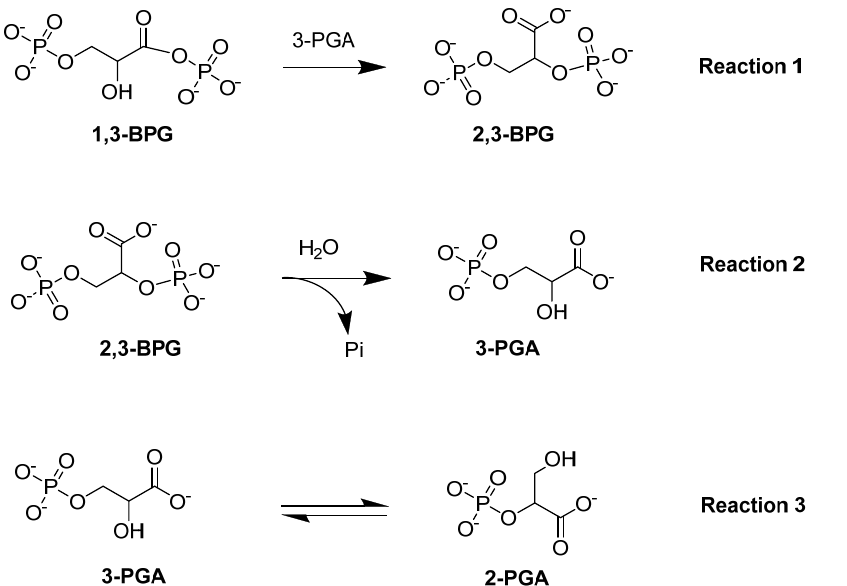
Figure 5. BPGM-catalyzed reactions: synthase activity (Reaction 1), phosphatase activity (Reaction 2), and mutase activity (Reaction 3).